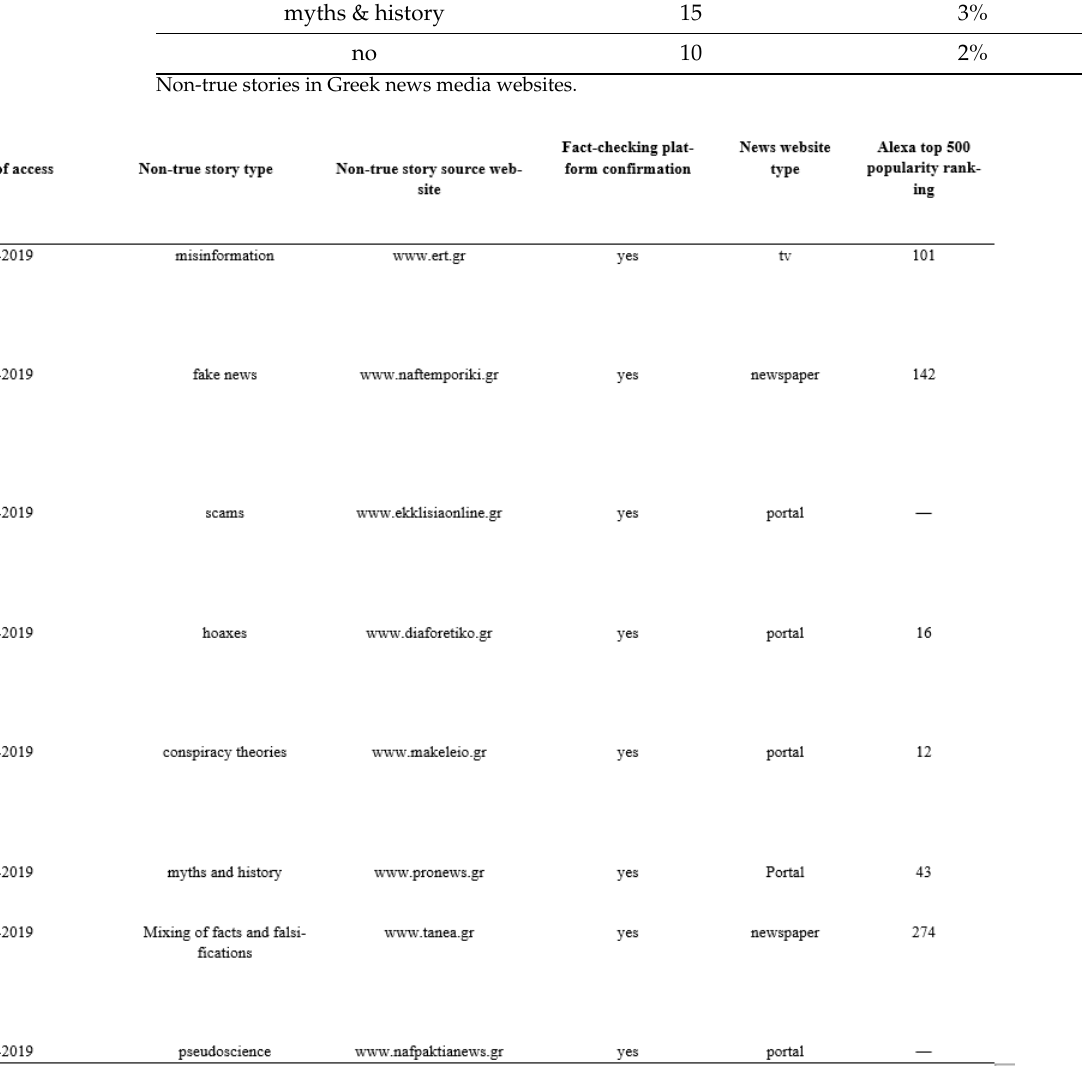
Figure 1. Data entry process sample.